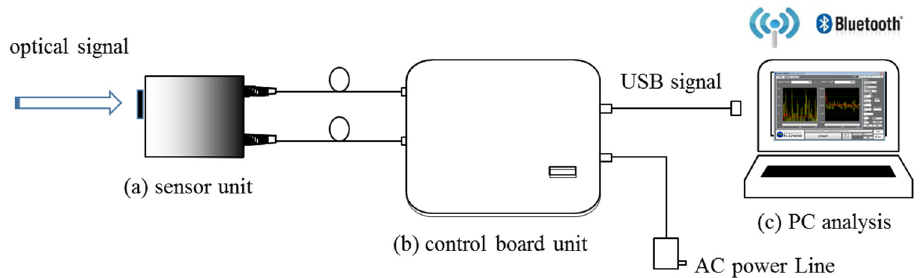
Figure 2. Arrangement of the simple monitoring system.